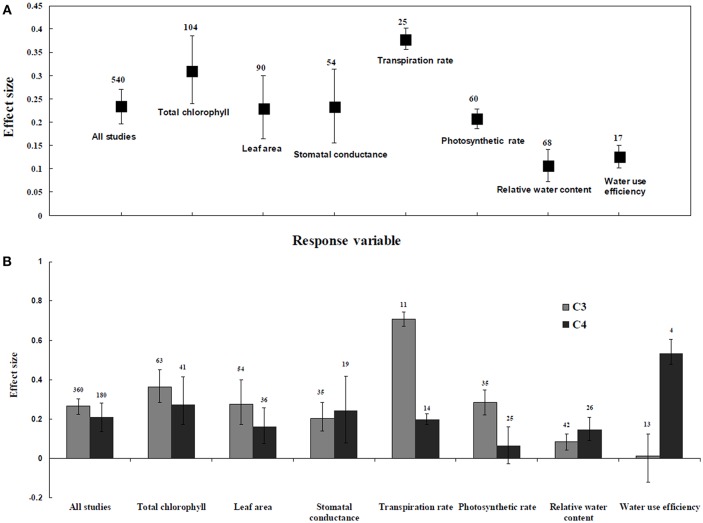
Comparative gas exchange and water status responses of arbuscular mycorrhizal fungi (AMF) inoculated plants under salt stress. (A) Overall analysis (B) C3 and C4 plants response. Error bars are means ± BS CIs. Where the CIs do not overlap each other, the effect size for a parameter is significant at P < 0.05. The number of trials included in the meta-analysis is denoted above the bar.